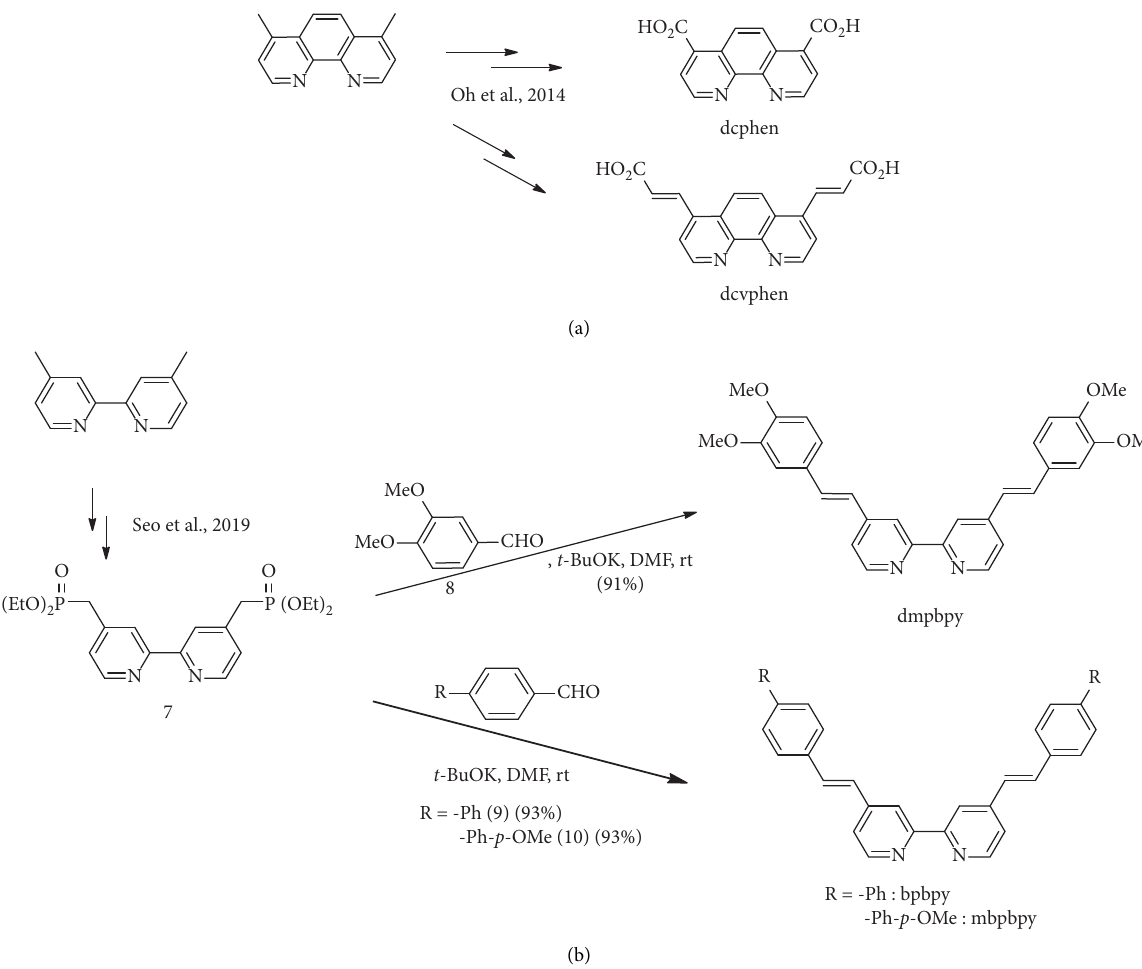
Scheme 1: Synthetic route for the preparation of the ligands under